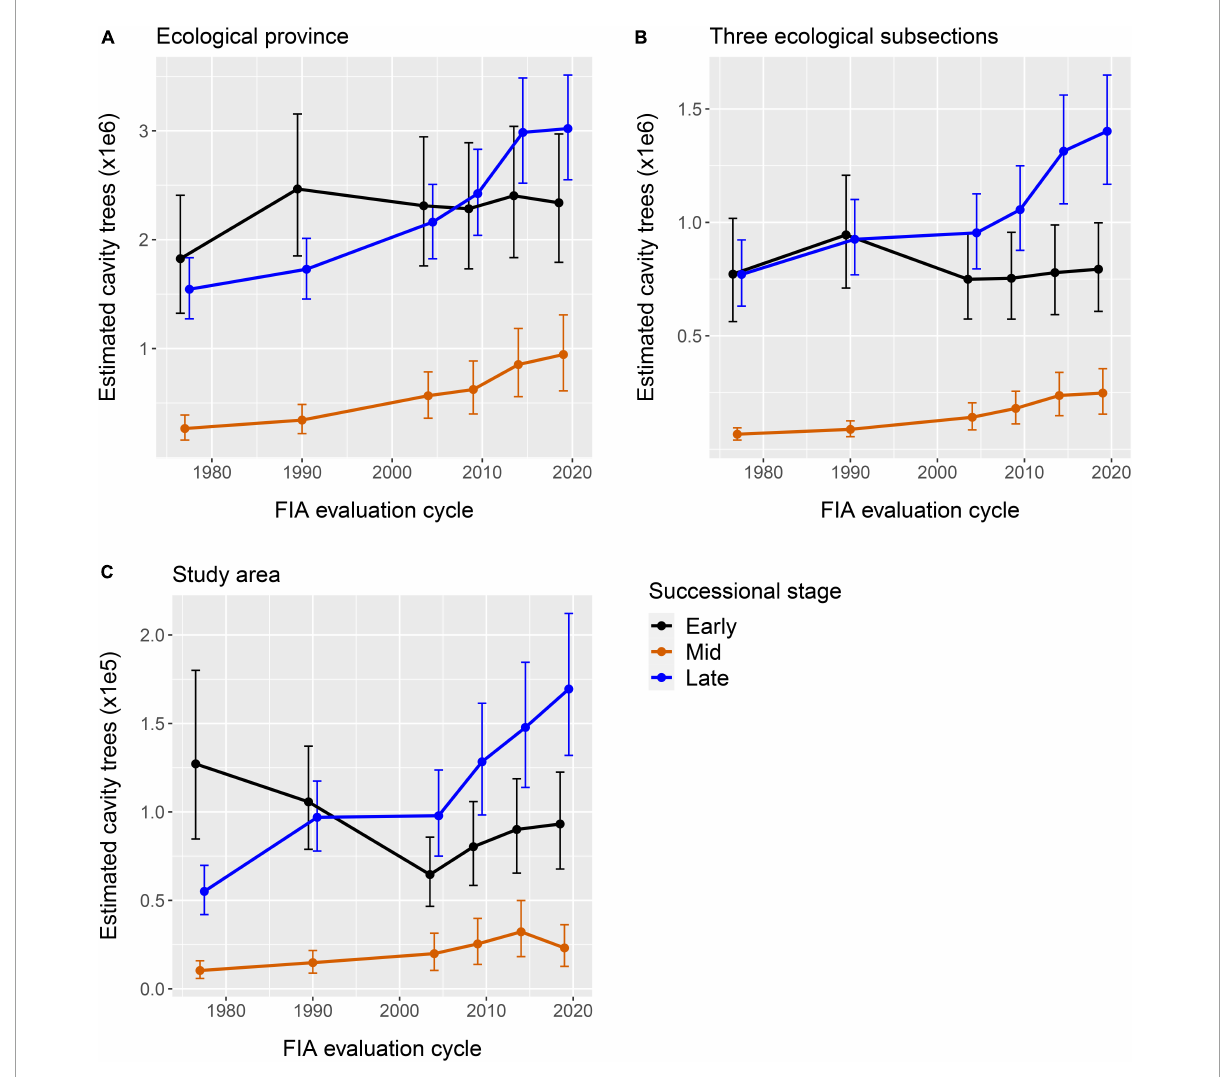
FIGURE3 Estimates (85% CrIs) of the abundance of tree stems (all species aggregated) which were suitable for nesting wood ducks in (A) a North Central MN, United States study area, (B) three ecological subsections that intersected the study area, and (C) the ecological province that contained the study